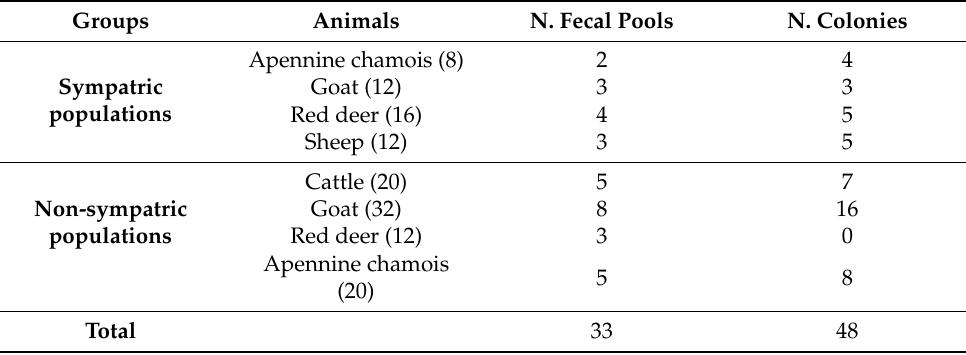
Table 2. Number of fecal pools and colonies selected for testing from each population under study. The number of collected samples for each population is reported in parentheses. N. Fecal